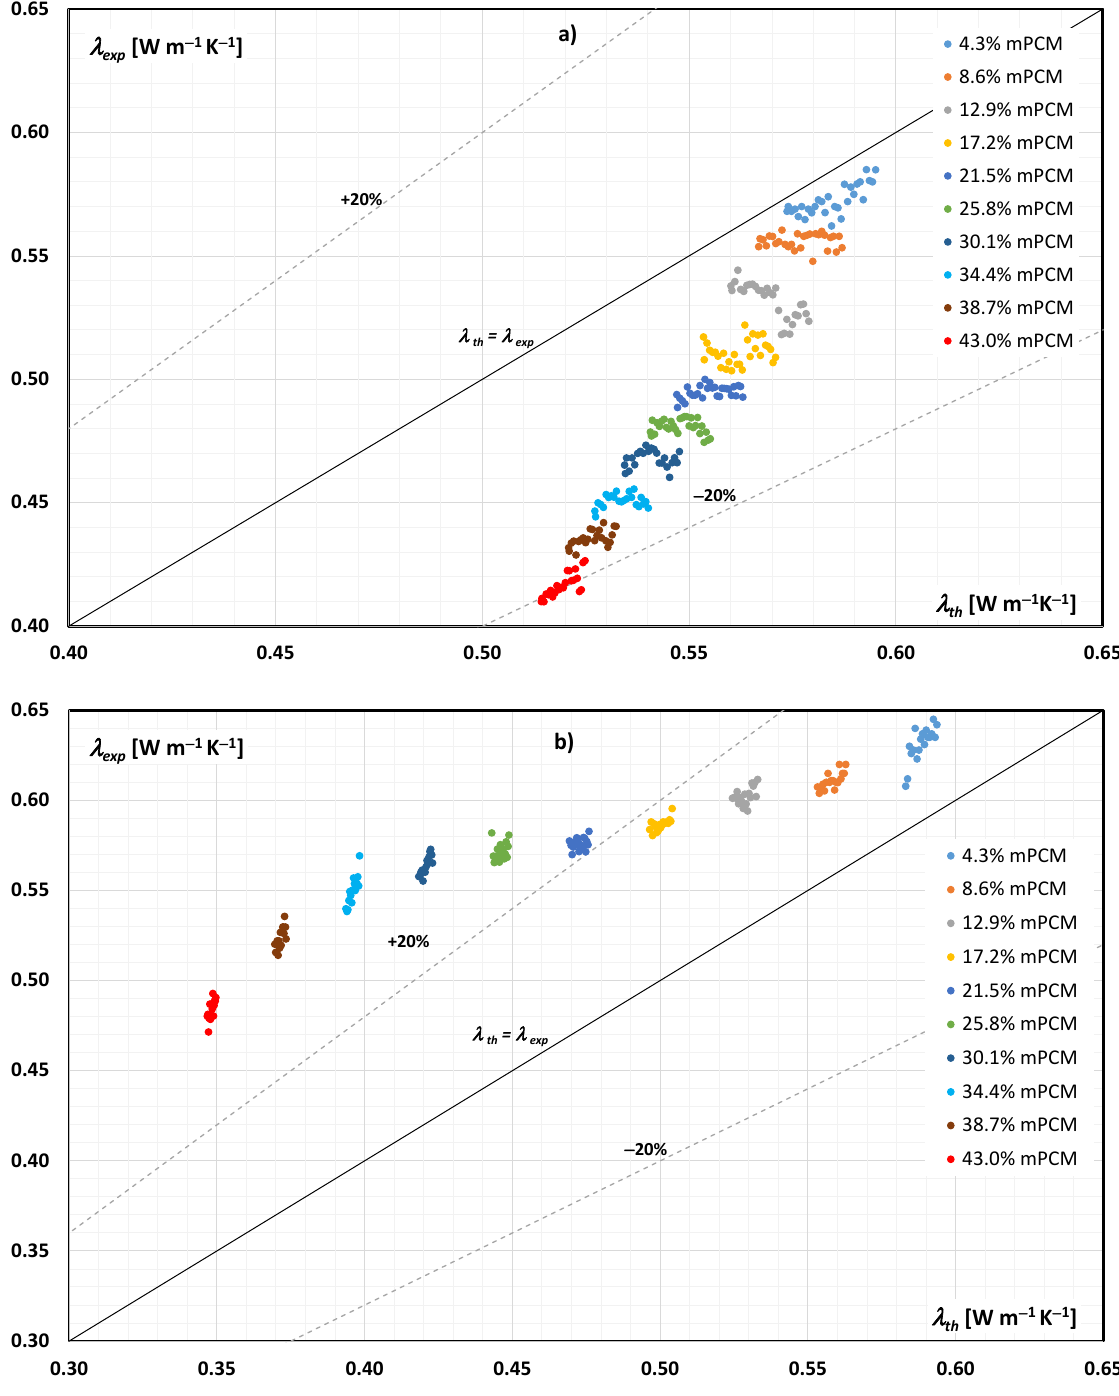
Figure 4. Comparison of the experimental and theoretical (according to Maxwell’s dependence) thermal conductivity of the aqueous mPCM slurry: ( a ) PCM in the form of a solid, ( b ) PCM in the form of a liquid.